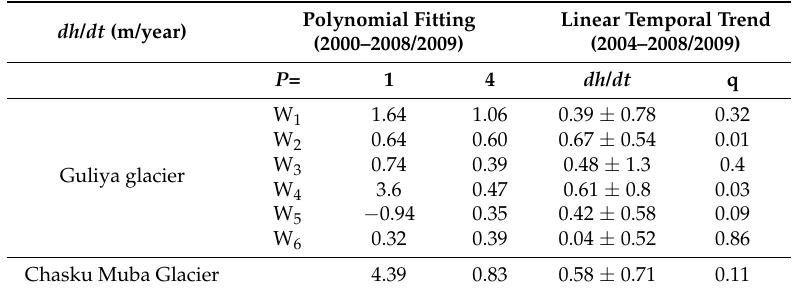
Table 4. Glacier elevation trends on Chasku Muba glacier with complex topography and Guliya glacier with a large area. q: probability value, the lower the value, the higher the credibility; W i : different segments on Guliya glacier illustrated in Figure